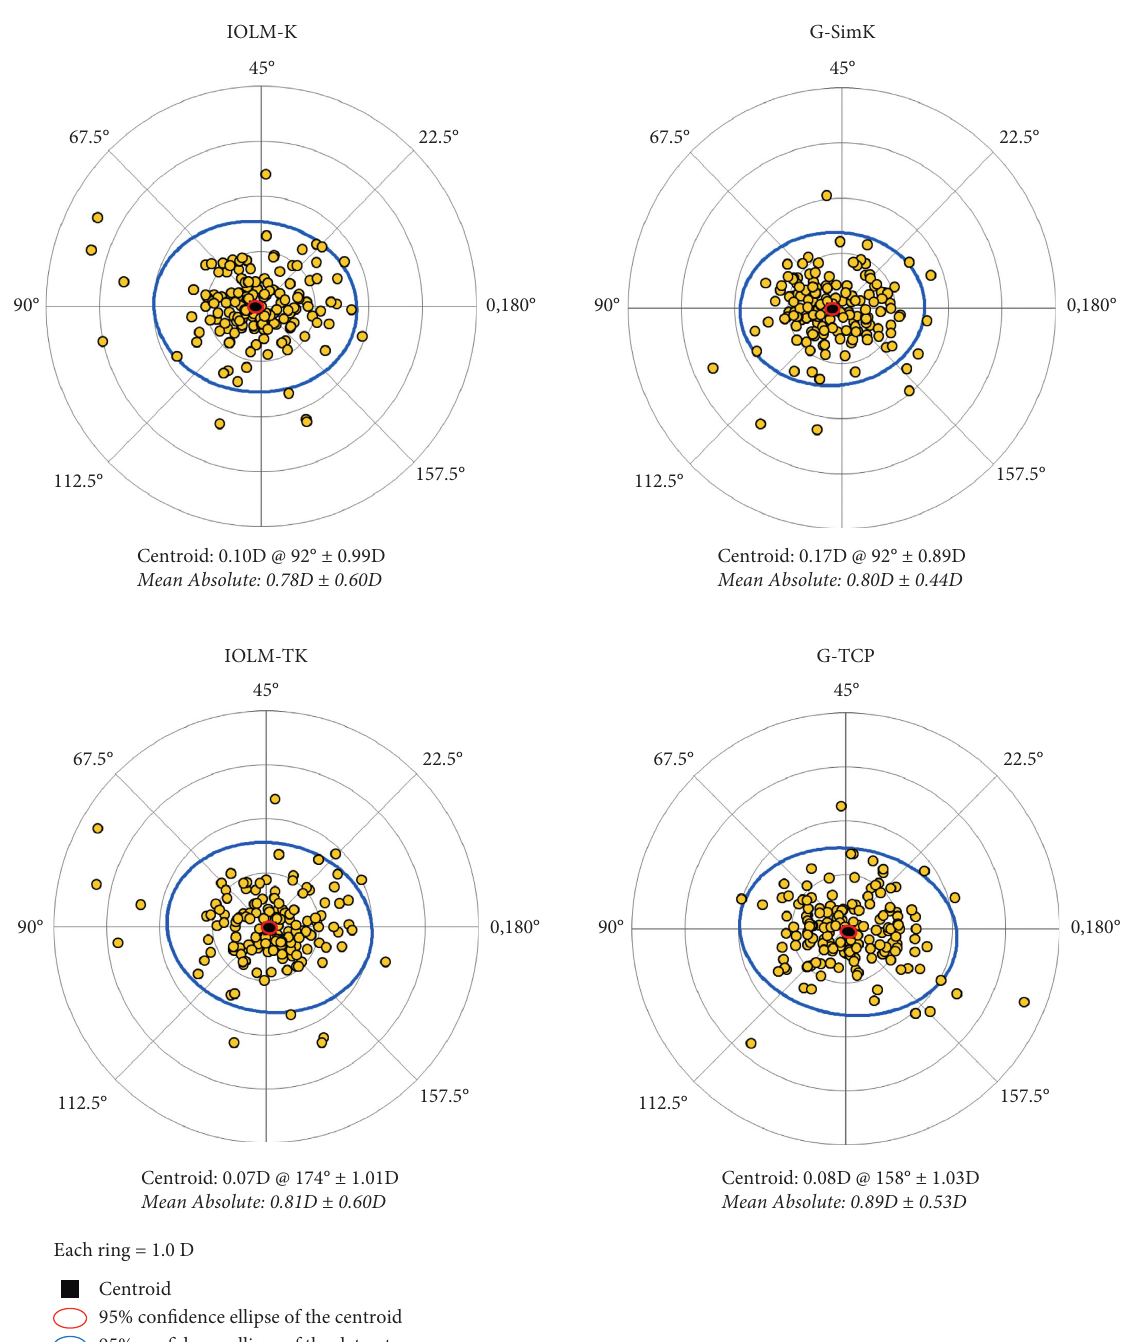
Figure 1: Double-angle plots of astigmatism. IOLM-K � IOLMaster Sim K G-SimK � Galilei G4 simulated keratometry. IOLM- TK � IOLMaster TruK. G-TCP � Galilei total corneal